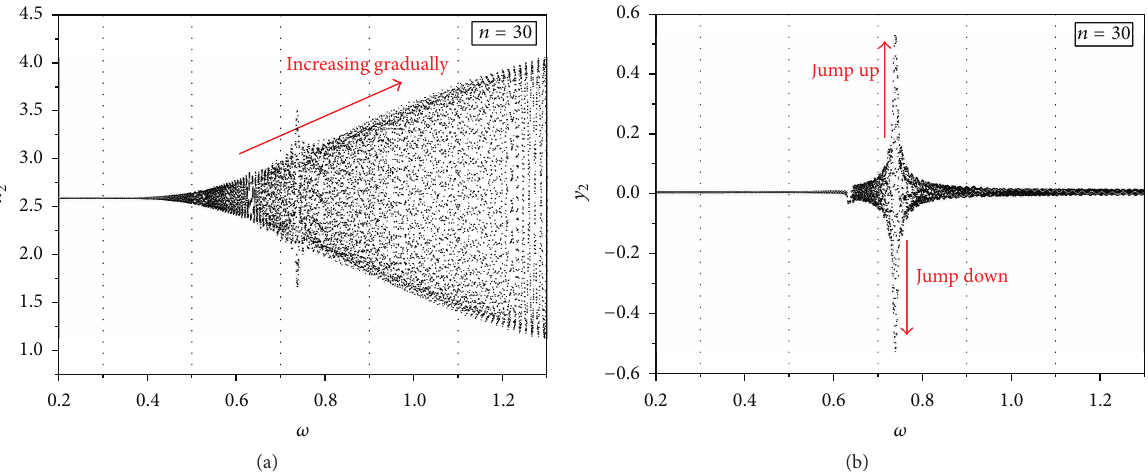
Figure 11: Steady-state response of displacement when 𝑛 = 30 : (a) 𝑥 2 and (b) 𝑦 2 .